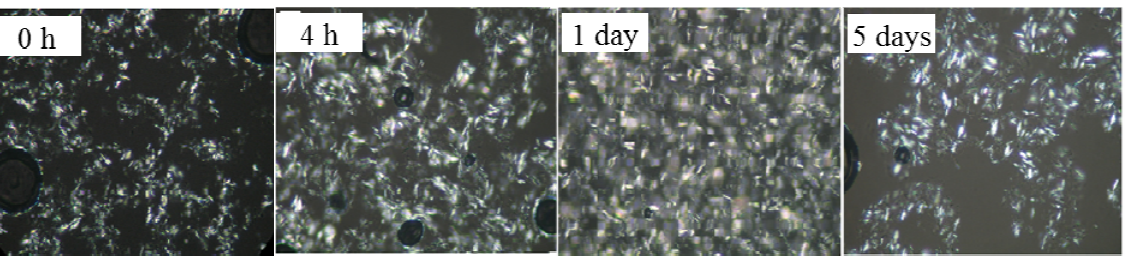
Figure 1. Greyscale PLM images of PS/PO oil control blend crystal networks stored for various periods: 0 h (onset of storage), 4 h, 1 day, 5 days. Magnification 500×.